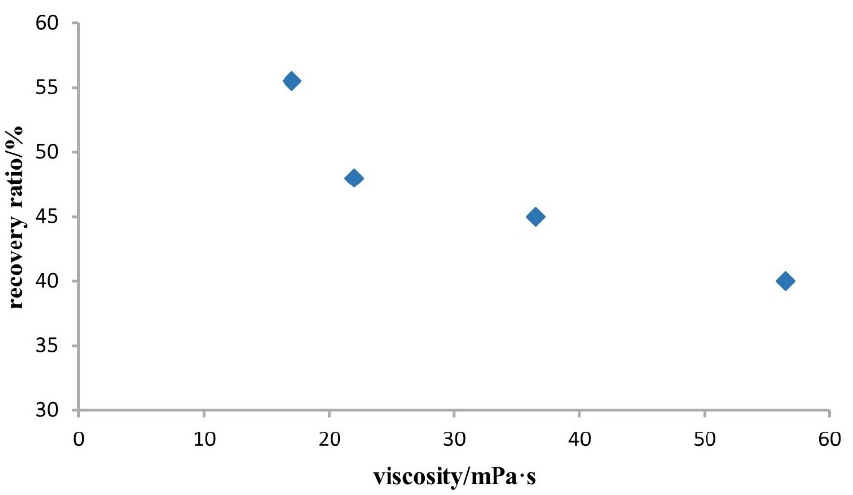
Figure 5. Heavy oil recovery under different viscosity.